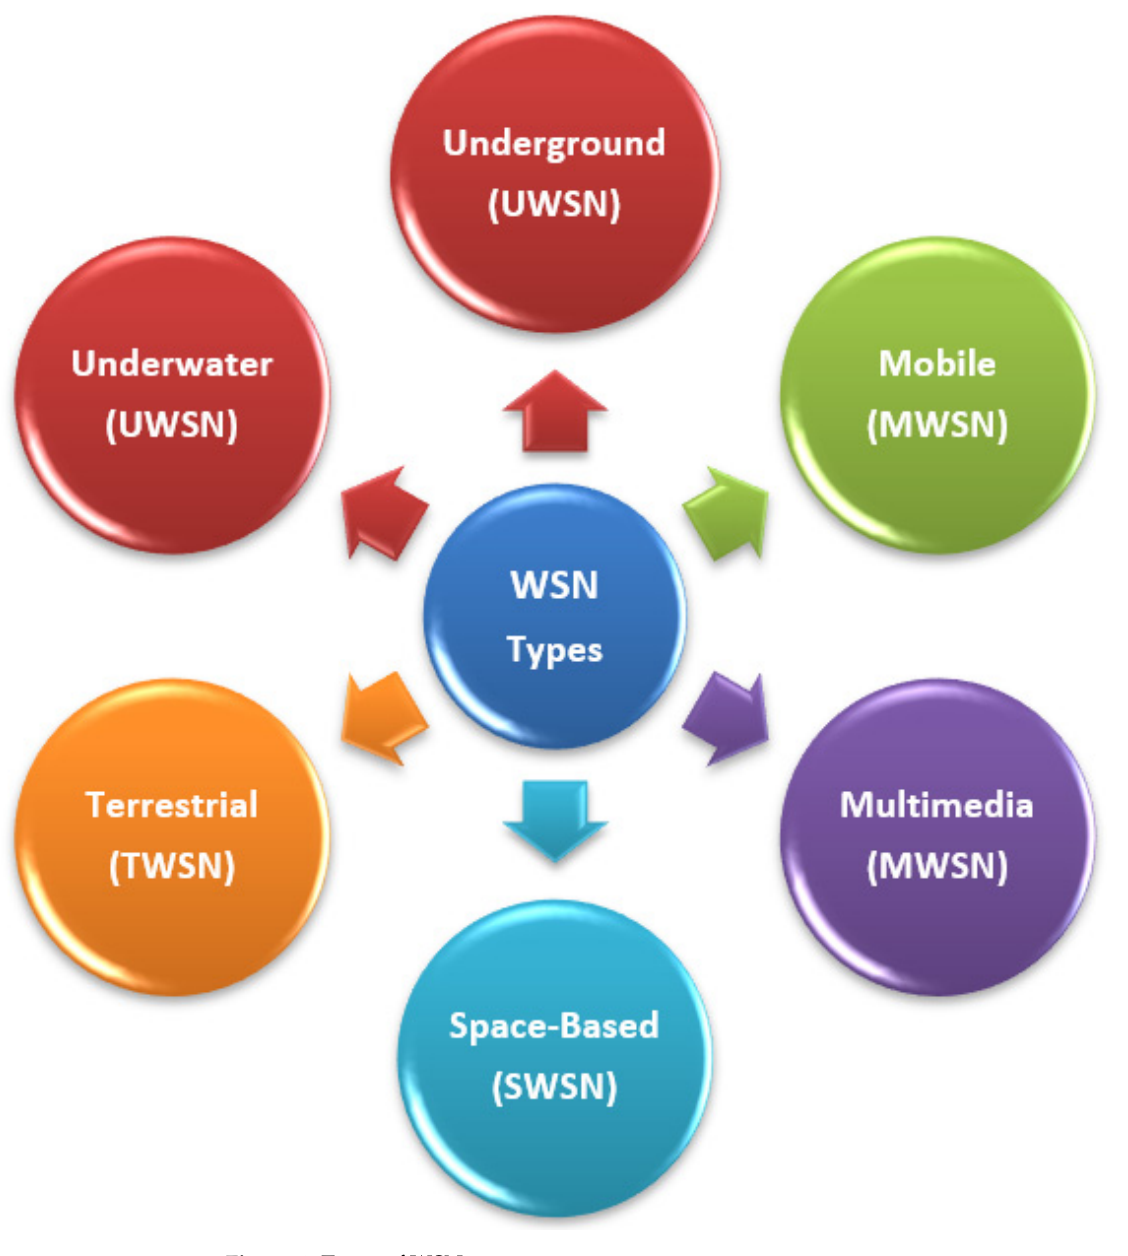
Figure 4. Types of Figure 4. Types of WSNs.